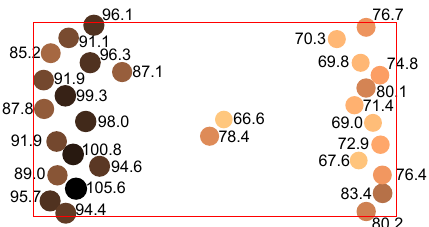
Figure 6. Optimal layout and relative power for a single wind direc- tion obtained after iteration 1. Relative power results are obtained from large-eddy simulations. Turbine locations are marked with coloured disk: size and colour scale by relative power. Plot bound- ary (red line) corresponds to boundaries of domain (cid:127) (see Fig. 1).